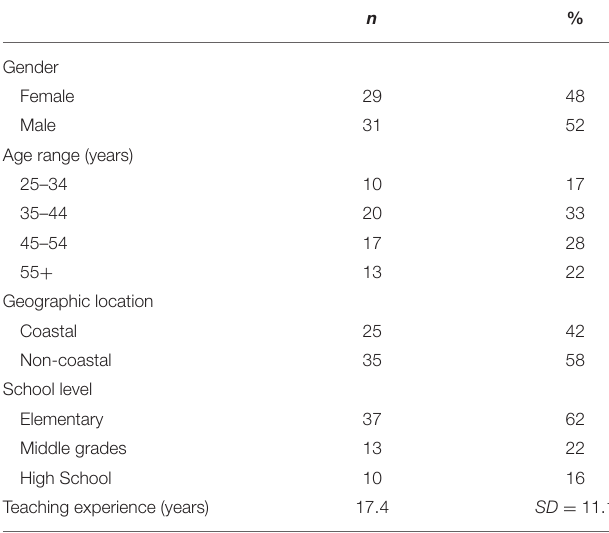
TABLE 1 | Demographics of survey respondents ( n =